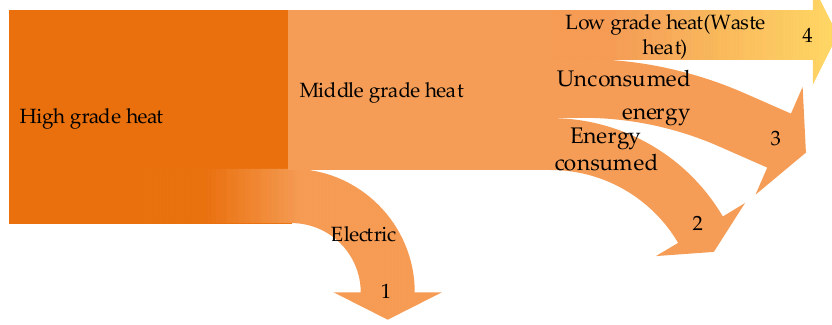
Figure 18. Combined cooling heating and power ( CCHP) system thermal ladder to use (not representative of the specific ratio).